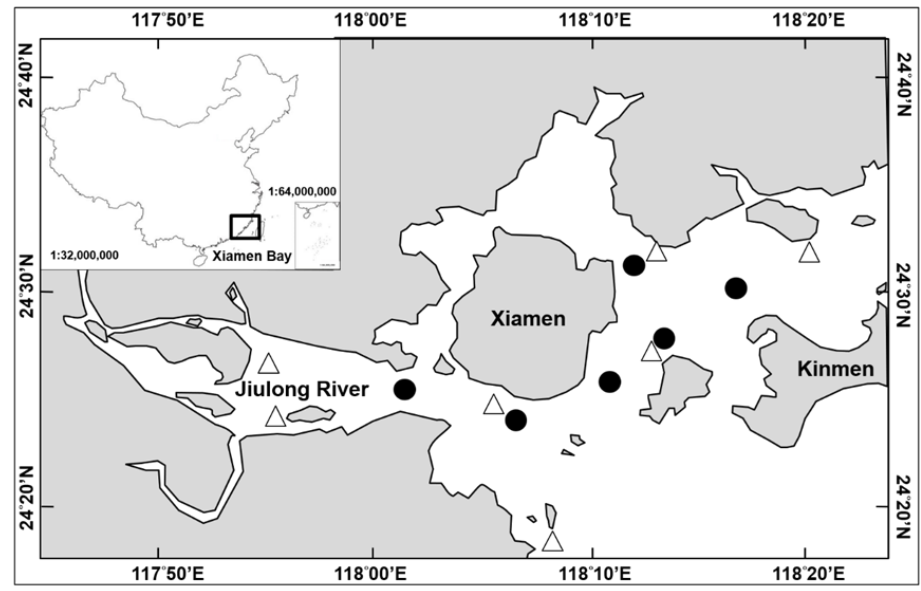
Figure 1. Map showing the location of the sample stations ( ∆ : 2006-2007; • : 2016-2017) in Xiamen Bay.